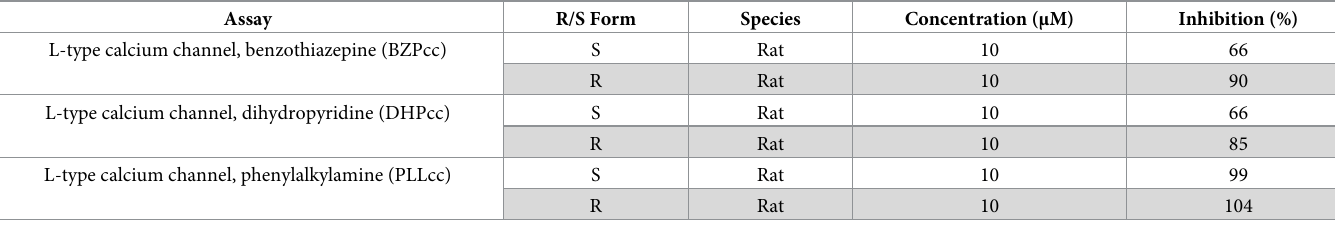
Table 3. Radioligand assay of R-Vera and S-Vera binding on three L-type calcium channels. Assay